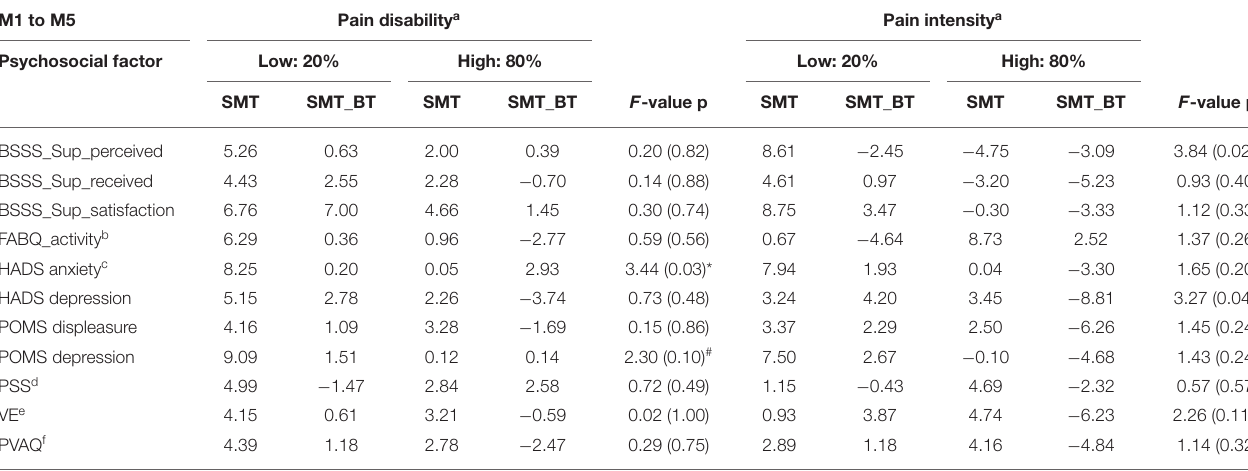
TABLE 3 | Interactions-metrics of intervention effects for subjective pain disability and pain intensity 24 weeks (M5) after the intervention (20%, 80% quantiles). M1 to M5 Pain disability a Pain intensity a Psychosocial factor Low: 20% High: 80%